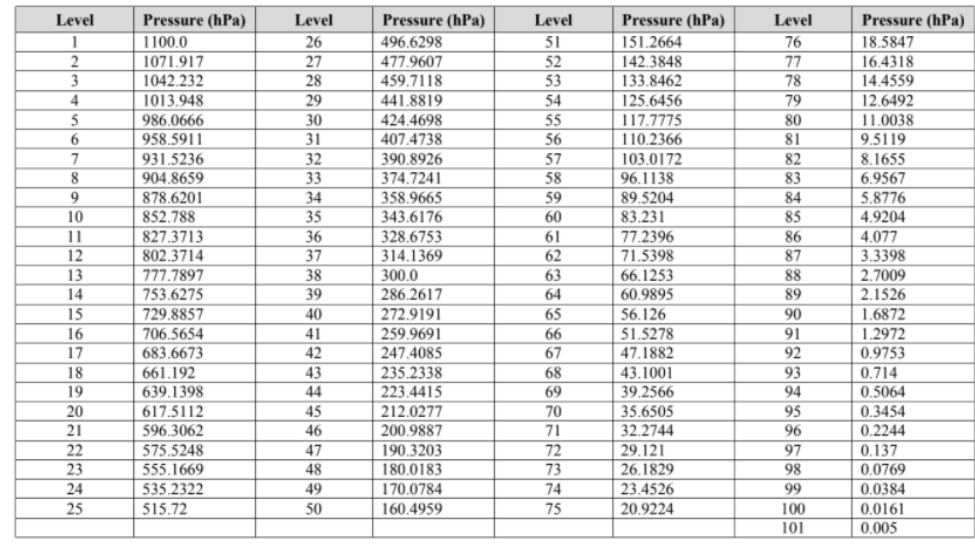
Figure 3. Vertical data pressure levels [4].